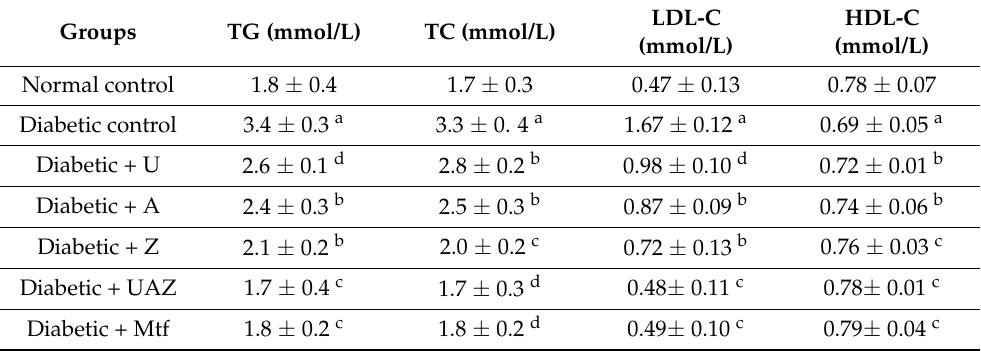
Table 4. Effects of U, A, and Z and UAZ on serum contents of TG, TC, LDL-C, and HDL-C for lipid